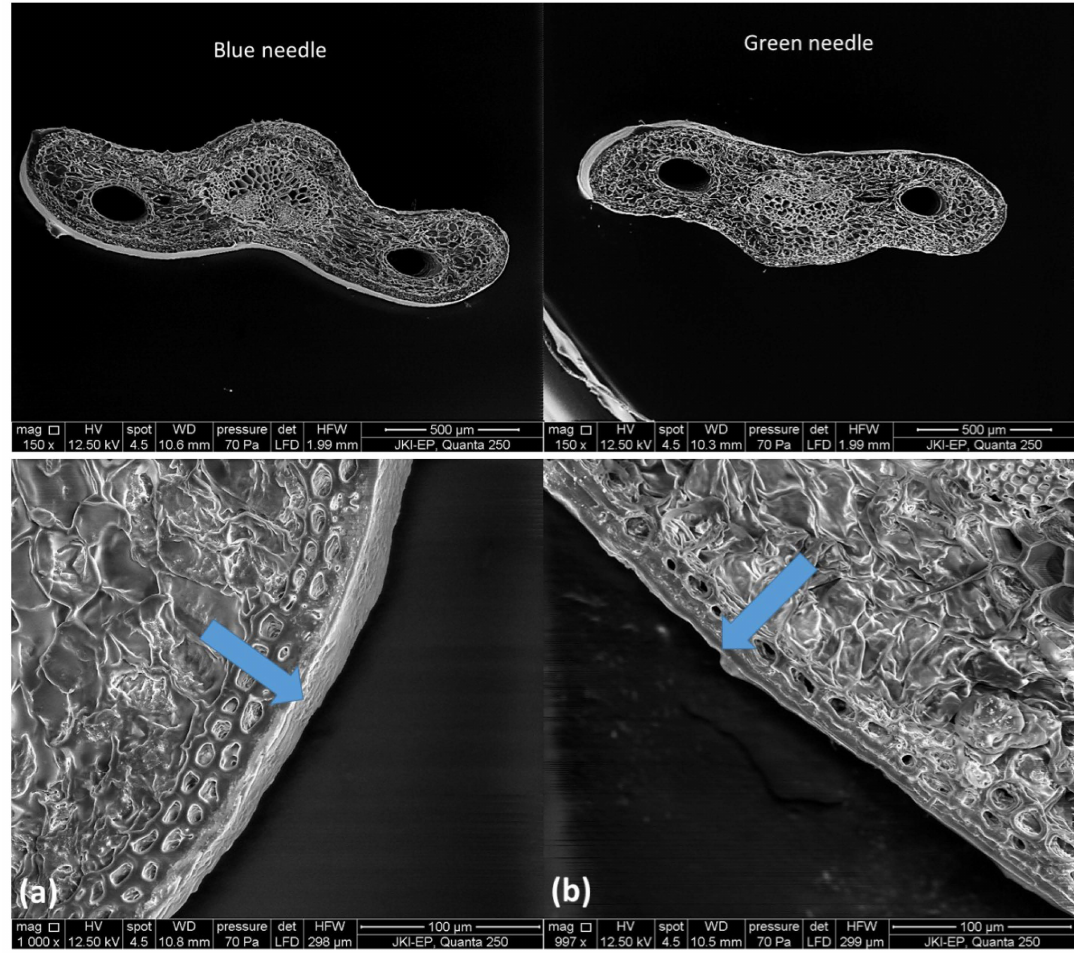
Figure 9. Cuticle (blue arrows) on two needles from subalpine fir ( Abies lasiocarpa ) from the provenance trial at Jønsberg. The cell layers beneath the cuticle are epidermis, hypodermis and mesophyll, respectively. Scale bar and other parameters (mag = magnitude, HV = high voltage, spot, WD = working distance, pressure, det, LFD = large field detector and HFW = horizontal field with) are given below each image. ( a ) Blue needle; ( b ) green needle. Photos: Corina